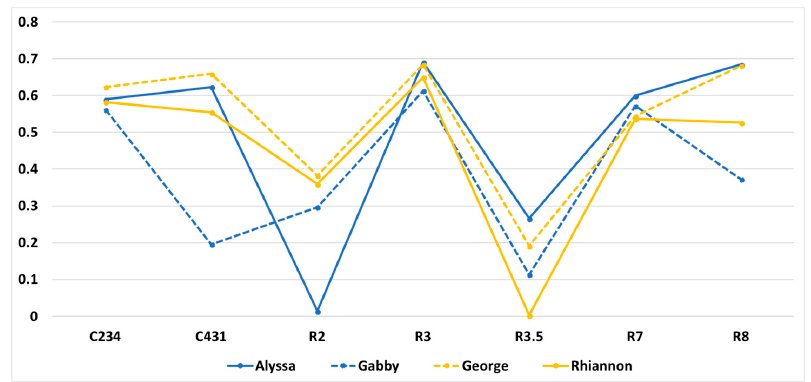
Figure 7. Normalized sigmoid gesture time spent rate for Alyssa, Gabby, George, and Rhiannon. A score of 0.5 represents the ‘time spent’ performance at the average for the group ( N = 24).